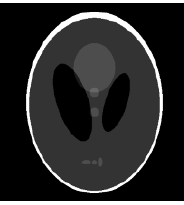
Fig. 11 “Phantom” image used in this experiment. Its gradient is unknown, so we approximate it numerically by first-order forward differences. We used this dataset for comparing preconditioners, for different image sizes, from 64 × 64 to 4096 ×